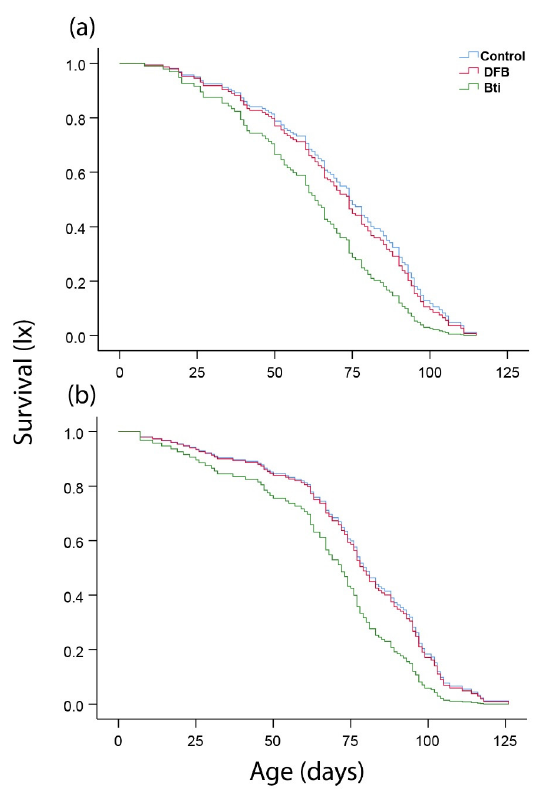
Figure 1. Male ( a ) and female ( b ) age-specific survival of Culex pipiens f. molestus populations that were either selected against diflubenzuron (DFB) and Bti for three successive generations or not (control). Adults were maintained in pairs (male and female) at the same place (warehouse) where they developed as larvae during winter, having access to 5% sugar solution. For the control, DFB and Bti selected populations, 49, 30 and 47 pairs were considered. Table 4. Longevity parameters of Culex pipiens f. molestus populations that were either selected against diflubenzuron (DFB) and Bti for three successive generations or not (control). Adults were maintained at the same place (warehouse) where they developed as larvae during winter, having access to 5% sugar solution. Within sex, different letters indicate significant differences (pairwise comparisons log-rank test, p < 0.05).